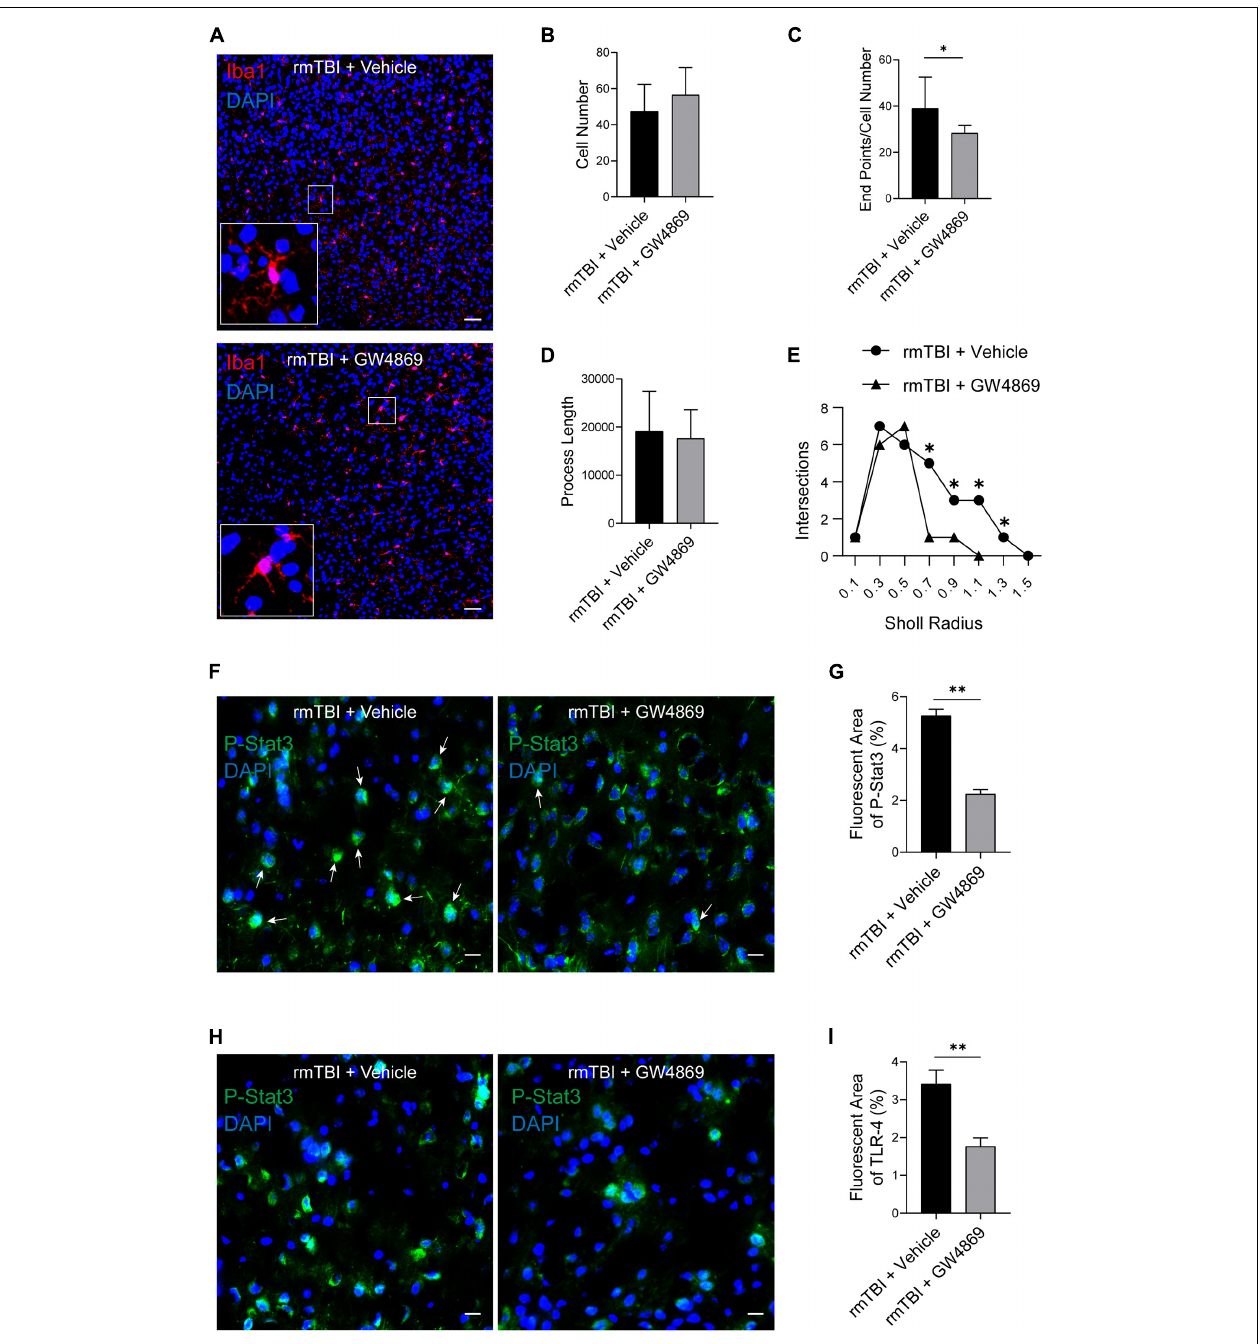
FIGURE 6 | (A) Confocal images of Immunofluorescence stained microglia in the cerebral cortex of the mice from rmTBI + Vehicle group and rmTBI + GW4869 group at 1 dpi. Iba1 (red) + staining indicates microglia, and DAPI (blue) staining indicates nuclei. Scale bar, 50 µ m. (B) Iba1 positive cells were counted and bar graph showing that there are no difference of Iba1 positive cell number between rmTBI + Vehicle group and rmTBI + GW4869 group. (C) Endpoints of microglia were counted by Image J, bar graph showing that the value of Endpoint/Cell Number in rmTBI + GW4869 group is lower than that in rmTBI + Vehicle group. (D) Total process lengths were measured by Image J and there are no difference of process length between rmTBI + Vehicle group and rmTBI + GW4869 group. (E) Sholl analysis was measured by Image J and line graph showing intersections of rmTBI + Vehicle group and rmTBI + GW4869 group. (F) Images of Immunofluorescence stained p-stat3(green) in the cerebral cortex of the mice from rmTBI + Vehicle group and rmTBI + GW4869 group at 1 dpi. White arrow showing p-stat3 and nuclear colocalisation. Scale bar 20 µ m. (G) Bar graph showing that the immunofluorescence intensity of p-stat3 in rmTBI + GW4869 group is significantly lower than that in rmTBI + Vehicle group. (H) Images of Immunofluorescence stained toll-like receptor 4 (green) in the cerebral cortex of the mice from rmTBI + Vehicle group and rmTBI + GW4869 group at 1 dpi. Scale bar 20 µ m. (I) Bar graph showing that the immunofluorescence intensity of TLR-4 in rmTBI + GW4869 group is significantly lower than that in rmTBI + Vehicle group. Mean ± SD. n = 6 mice per group. ∗ p < 0.05, ∗∗ p <